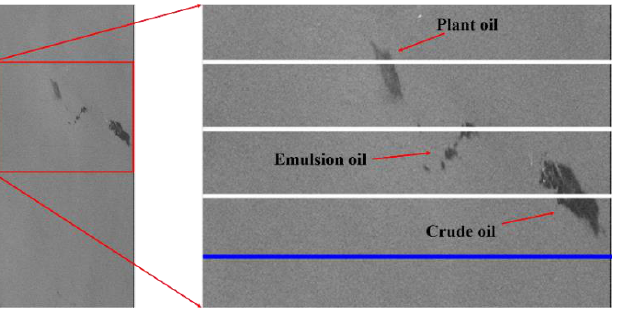
Figure 6. The Radarsat-2 SAR image used in this work. The three dark areas correspond to biological slick (upper left), emulsion oil (middle), and crude oil (lower right), respectively.